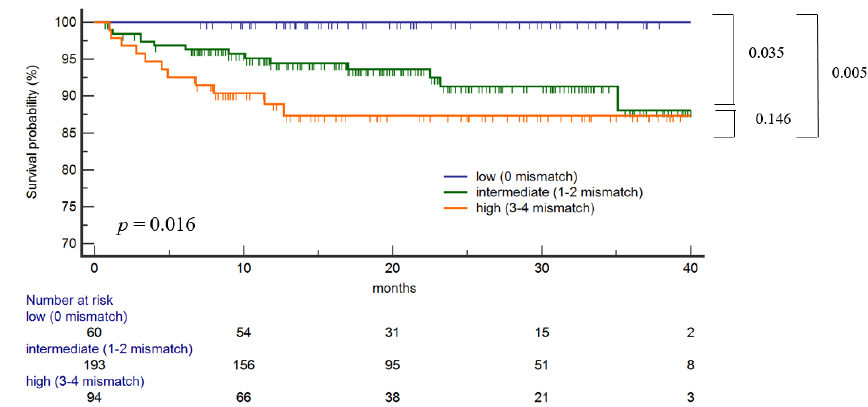
(Figure 1). A low risk of HLA-DR/DQ antigen mismatch (0 mismatches) was associated with significantly lower dnDSA-free survival than intermediate (1–2 mismatches) and high-risk (3–4 mismatches) groups ( p = 0.035, 0.005, respectively). However, there was no statistical difference in dnDSA-free survival between the intermediate (1–2 mismatches) and high-risk (3–4 mismatches) groups.